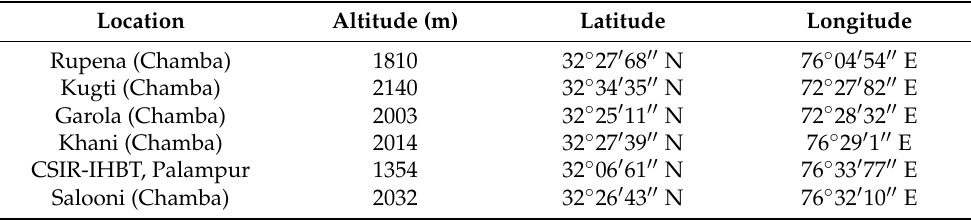
Table 4. Geophysical positioning of different locations of sample collection.